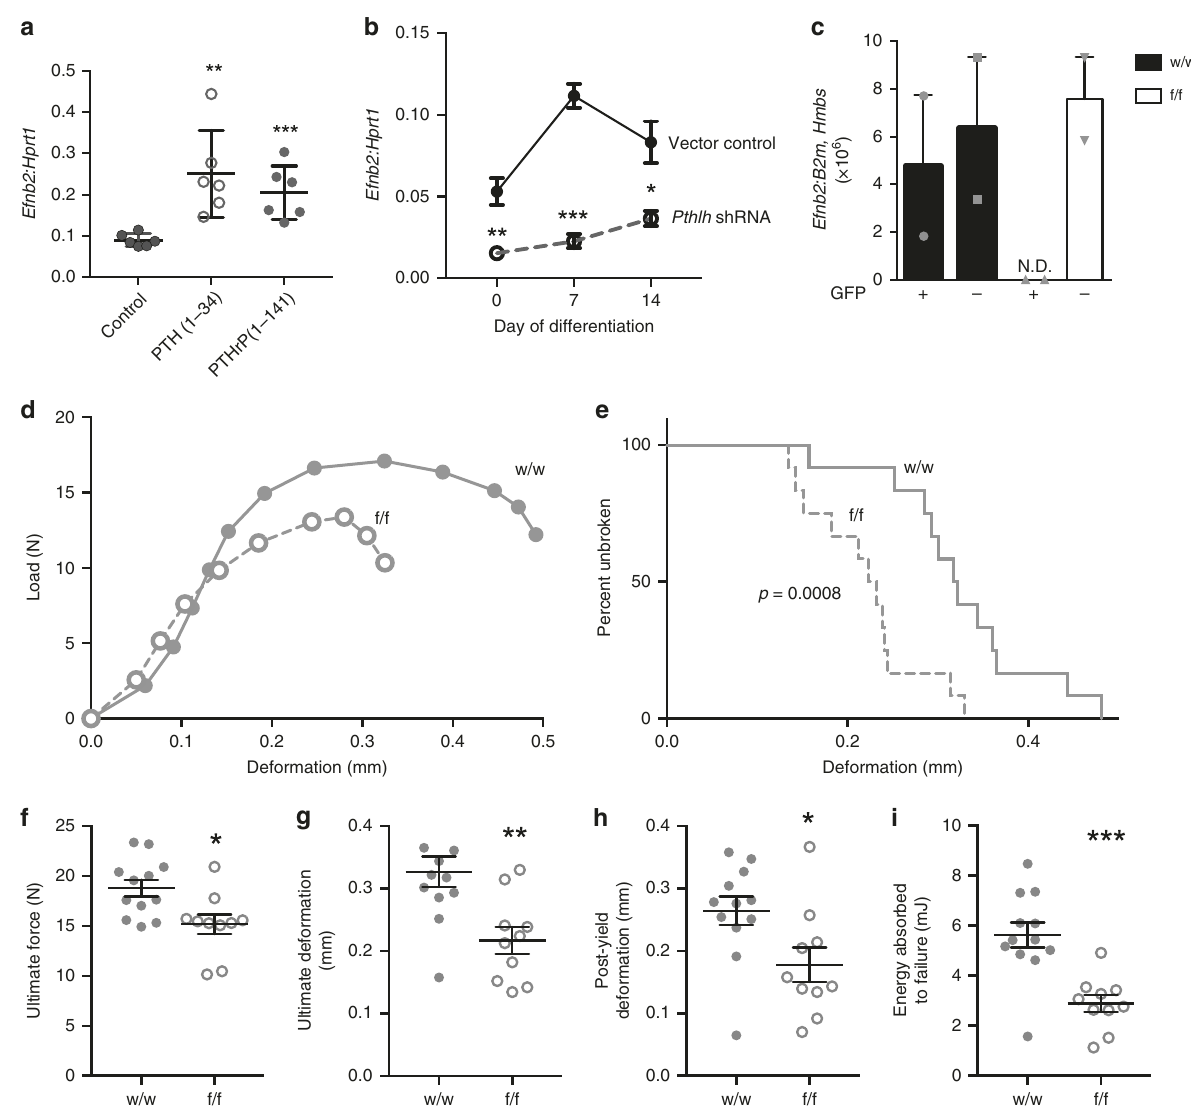
Fig. 1 Parathyroid hormone (PTH) and PTH-related protein (PTHrP) stimulate Efnb2 in osteocytes and bone strength is impaired in mice lacking EphrinB2 in osteocytes. a , b Efnb2 messenger RNA (mRNA) levels, relative to Hprt1 , in Ocy454 cells differentiated for 14 days and treated with 10 nM hPTH(1 – 34) or hPTHrP(1 – 141) for 6 h ( a ) and Ocy454 cells with stable short hairpin RNA (shRNA) knockdown of PTHrP ( Pthlh ) at 0, 7, and 14 days of differentiation ( b ). Data are mean ± SEM, n = 6 replicates; representative of three independent experiments; * p < 0.05, ** p < 0.01, *** p < 0.001 compared to control by Student ’ s t test. c Efnb2 mRNA levels in green fl uorescent protein-positive (GFP + ) osteocytes isolated from Dmp1Cre.DMP1-GFP-Tg.Efnb2 w/w (w/w) and Dmp1Cre.DMP1-GFP-Tg.Efnb2 f/f (f/f) mice compared to GFP − cells. ND = not detected. Data mean ± SEM of two experiments, n = 6 mice/group; pooled. d Average load – deformation curve from three-point bending tests (each dot represents the average for the noted sample group; error bars excluded to highlight the shape of curves) of femora from 12-week-old female Dmp1Cre.Efnb2 f/f (f/f) mice and Dmp1Cre controls (w/w). e Kaplan – Meier curve showing percentage of unbroken femora with increasing deformation ( p value from Mantel – Cox log-rank test). f – i Calculated indices of bone strength: ultimate force ( f ), ultimate deformation ( g ), post-yield deformation ( h ), and energy absorbed to failure ( i ). Data are mean ± SEM, n = 10 – 12/group. * p < 0.05, ** p < 0.01, *** p < 0.001 vs. w/w controls by Student ’ s t